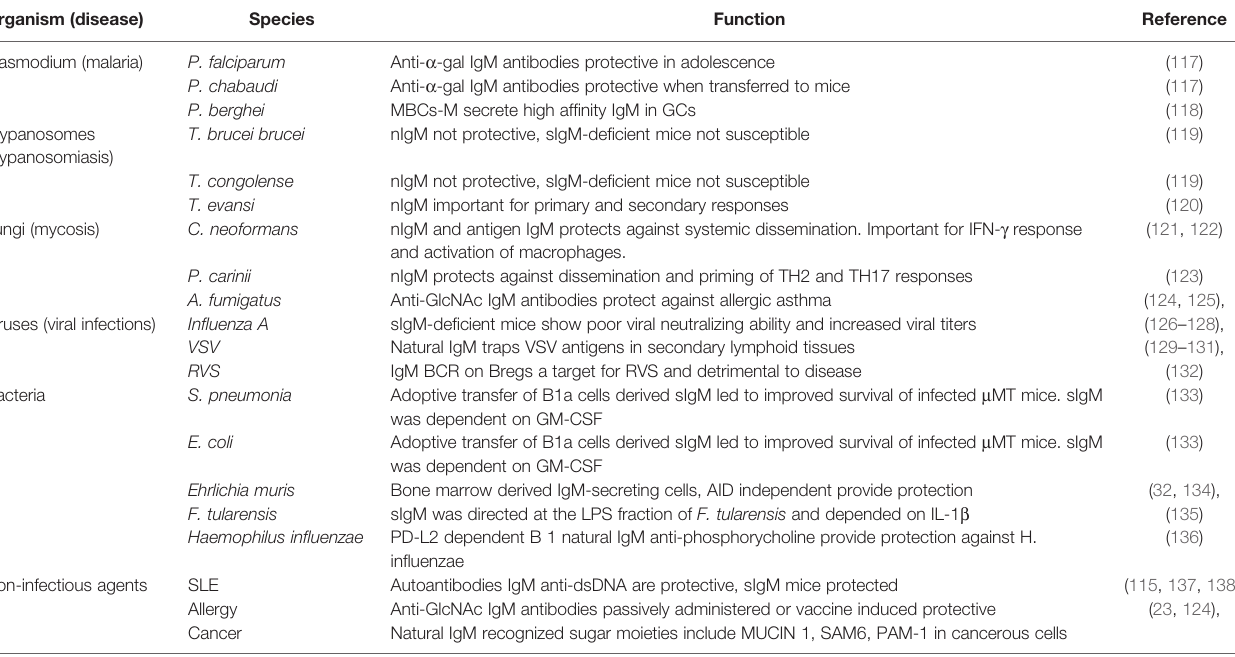
TABLE 1 | Role of immunoglobulin M (IgM) in infectious and non-infectious diseases. Organism (disease) Species